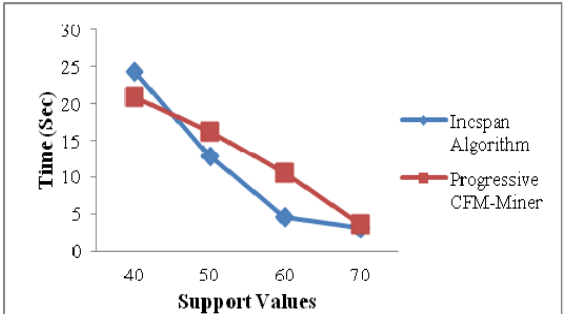
Fig.9. Generated Sequential Patterns with Different Support